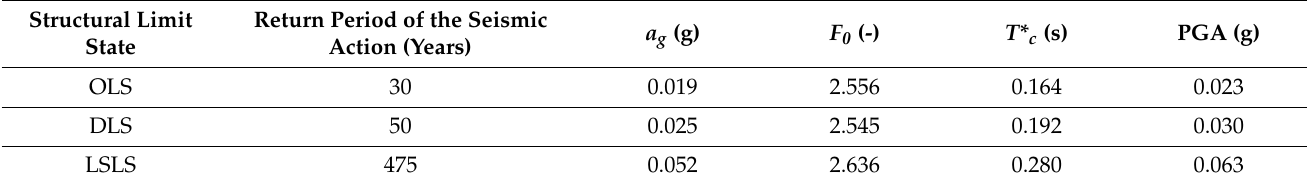
Table 4. Parameters defining the elastic response spectrum according to NTC [47] for the considered return periods of the seismic action.